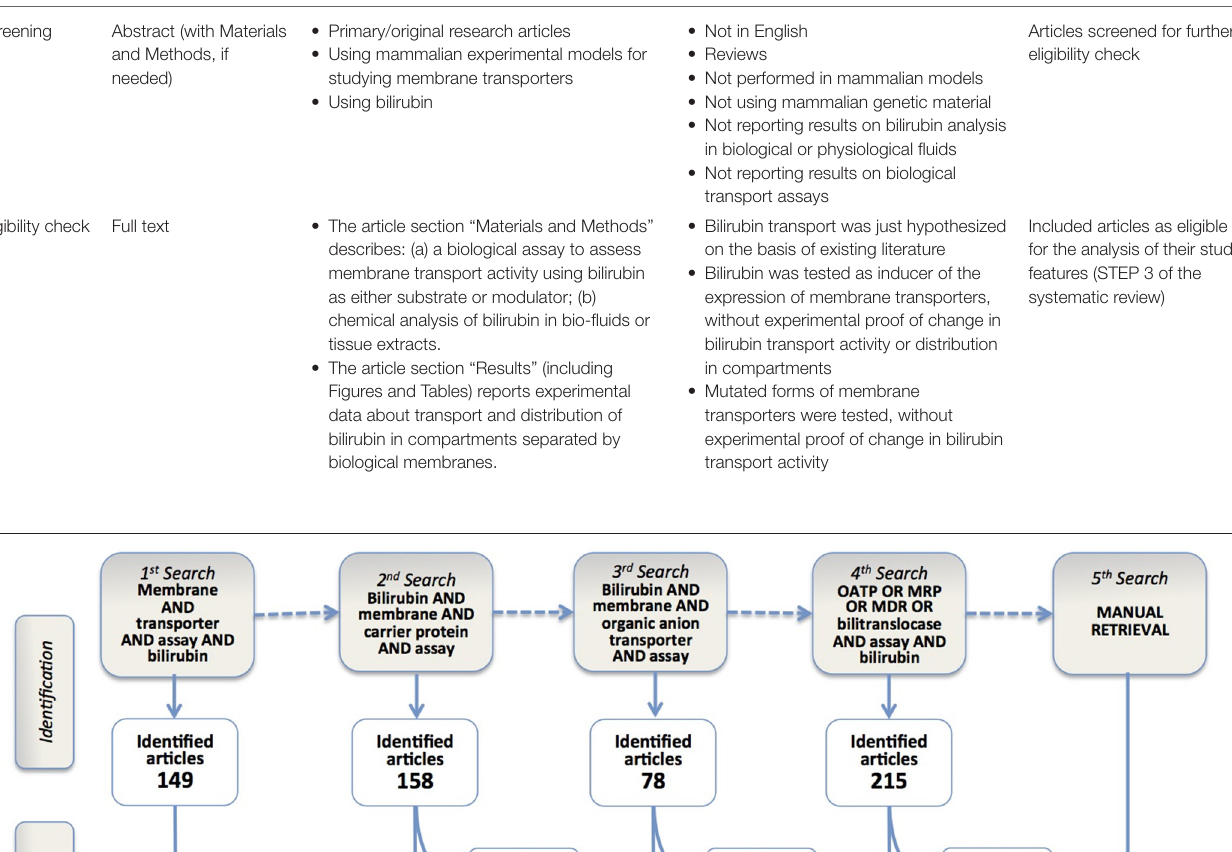
TABLE 2 | Selection strategy. Phase Out